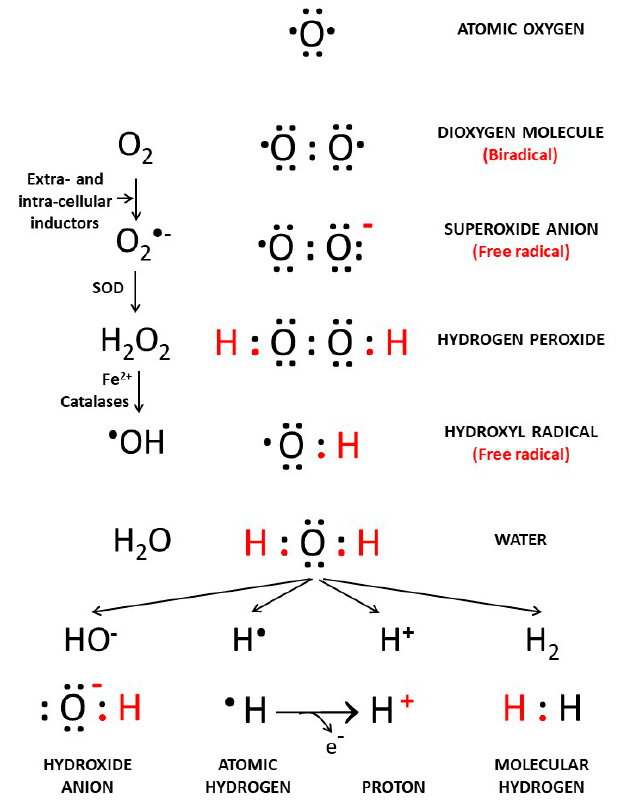
Figure 1. Reduction of O 2 to H 2 O, free radicals’ intermediates and hydrogen forms. Extra- and intra-cellular inductions interact with atomic oxygen (O 2 ) to promote formation of free radical derivatives such as superoxide (O 2 − • ), hydrogen peroxide (H 2 O 2 ), and the highly reactive hydroxyl radical (•OH).